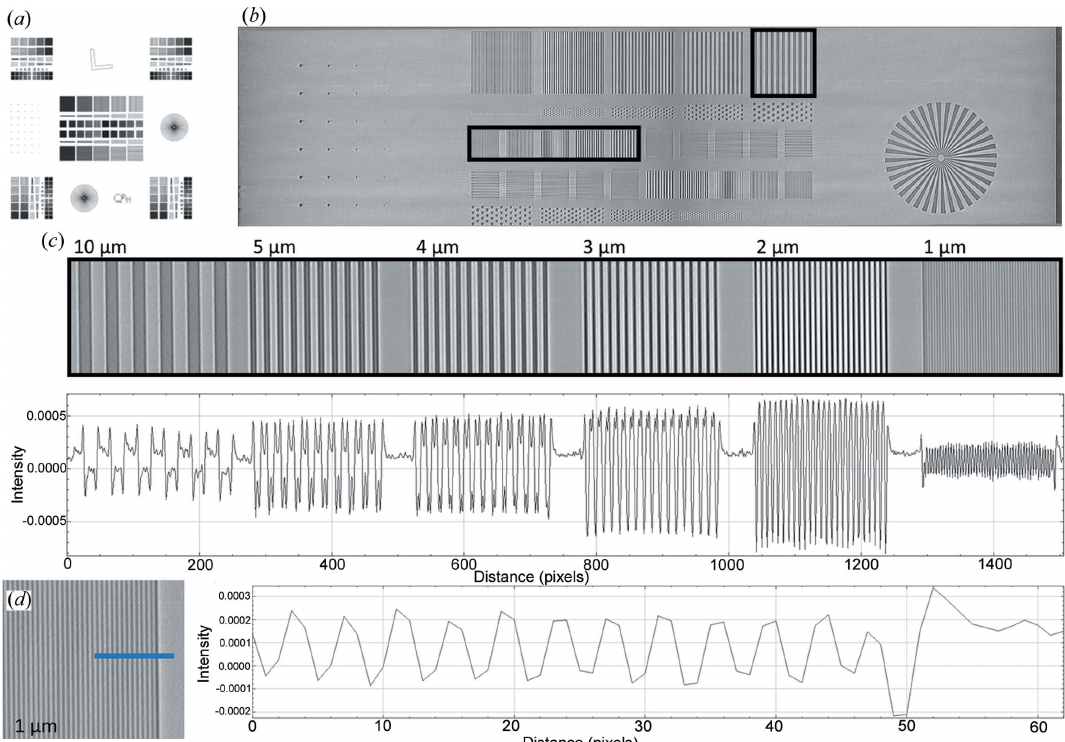
Figure 4 Verification of resolution utilizing a QRM bar pattern phantom. AQRM-manufactured phantom including line and point patterns, Siemens stars and an L edge ( a ) was scanned at the Berkeley ALS and locally reconstructed to characterize the resolution of the combined lens system and camera detector. A portion of the reconstructed phantom is presented ( b ) showcasing line pairs ranging from 10 to 1 m m in width. A line profile of the indicated regions is shown, validating resolution up to 1 m m ( c ). A smaller line profile taken across the 1 m m line pairs that highlights signal shape is shown ( d ). Signal at the edges of line pairs is enhanced by phase effects caused by the silicon–air interface. Pixel counts between line pairs confirm reconstruction at 0.5 m m, as each line of the 1 m m pattern is 2 pixels